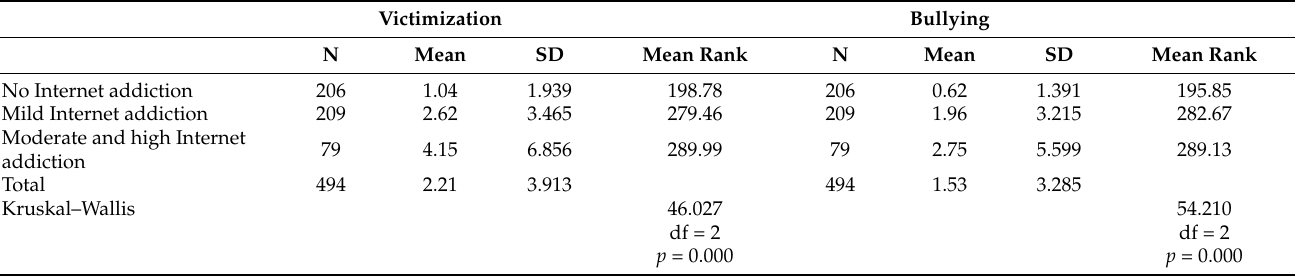
Table 6. Differences in the perpetration and experience of cyberbullying with regard to levels of Internet addiction. Victimization